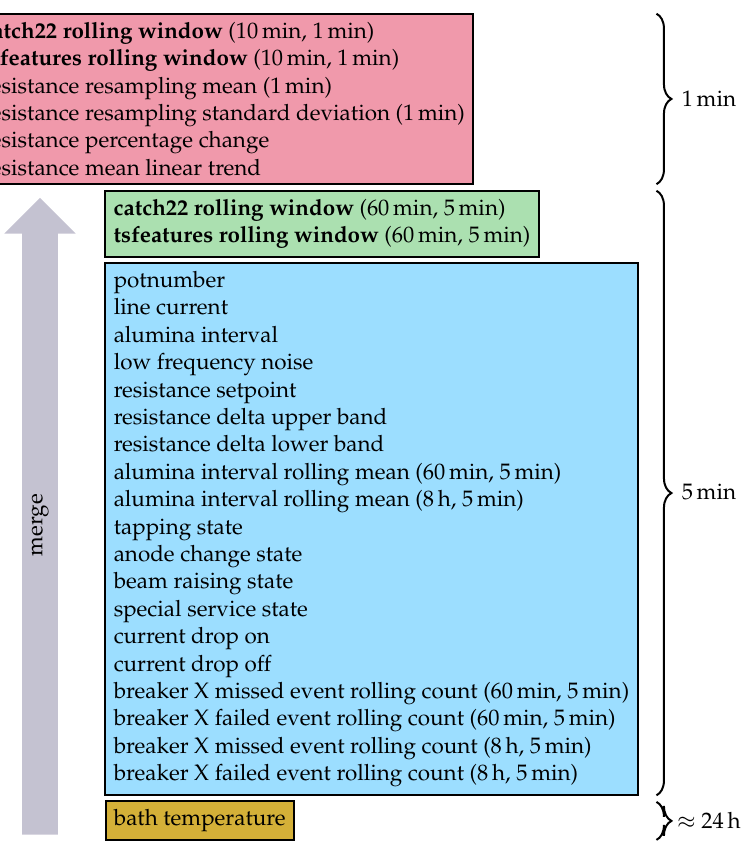
Figure 4. Features used as input for machine learning model.